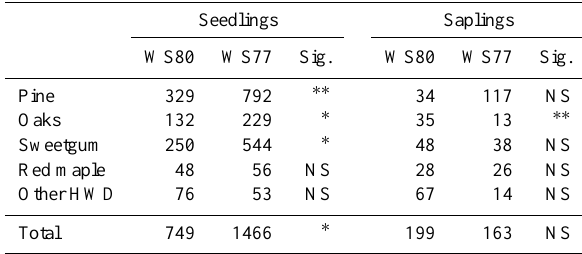
Fig. 5. Monthly rainfall totals in the two study watersheds grouped by the three eras; Pre: 1969-1991, Flip: 1992-2003, Flop: 2004- 2011. These data represent only concurrently measured rainfall